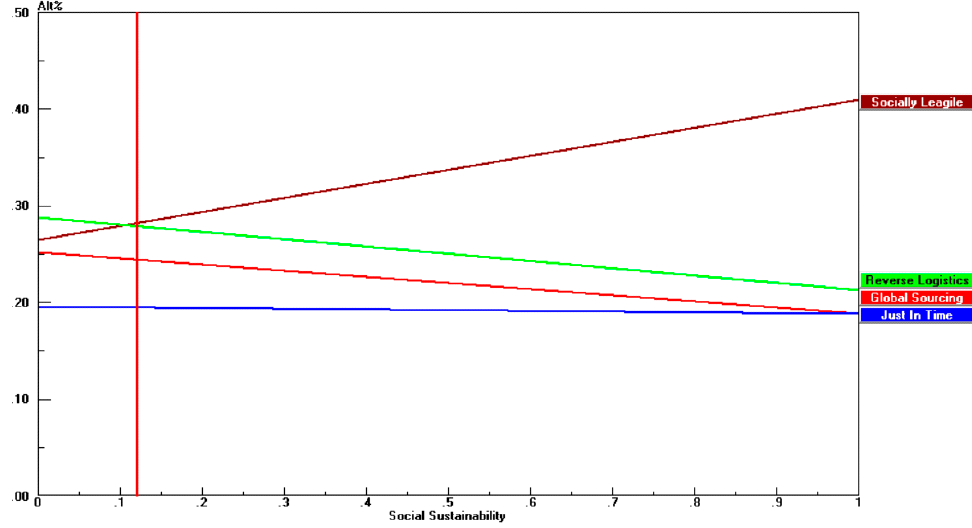
Figure 12. Sensitivity analysis of alternatives w.r.t. Social sustainability weight.